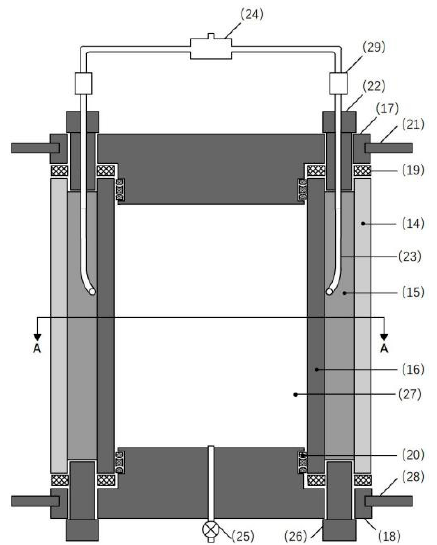
Figure 3. Profile of the simulated sample of the casing/cement sheath/formation assembly.